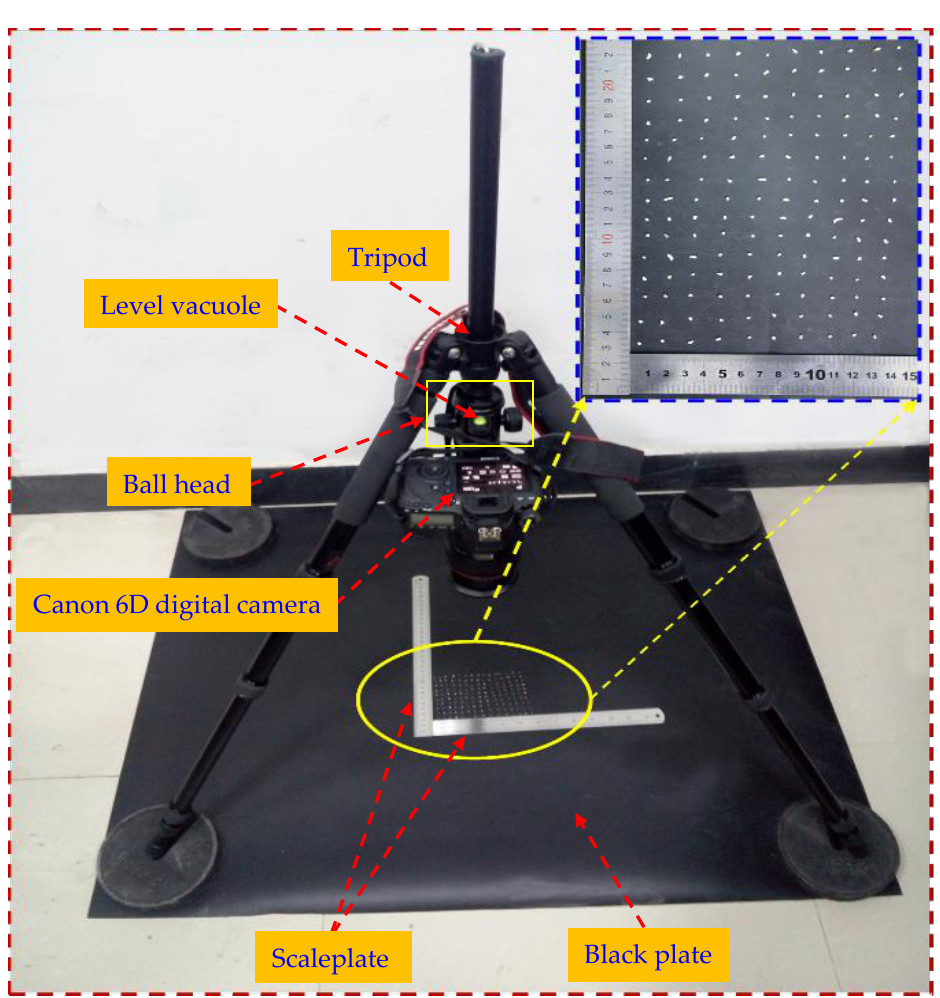
Figure 4. Two-dimensional image shooting device.